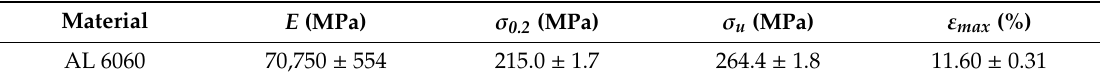
Table 3. Mechanical properties (mean and standard deviation).